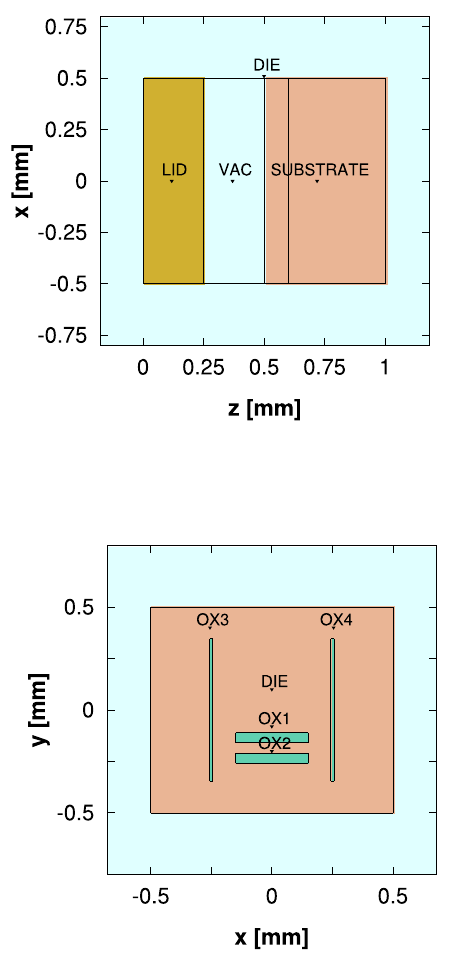
Fig. 4. RadFET geometry and materials: FLUKA model.